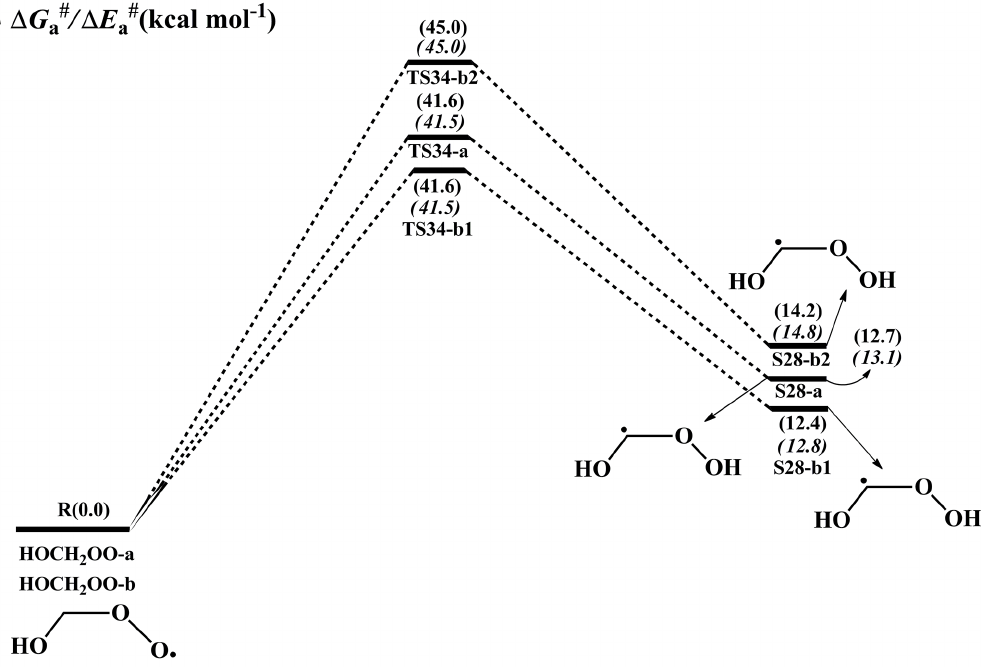
Figure 9. PES ( (cid:49)G # a and (cid:49)E # a , in italics) for the isomerization of an HOCH 2 OO radical predicted at the M06-2X/ma-TZVP//M06-2X/6- 311+G(2df,2p) level of